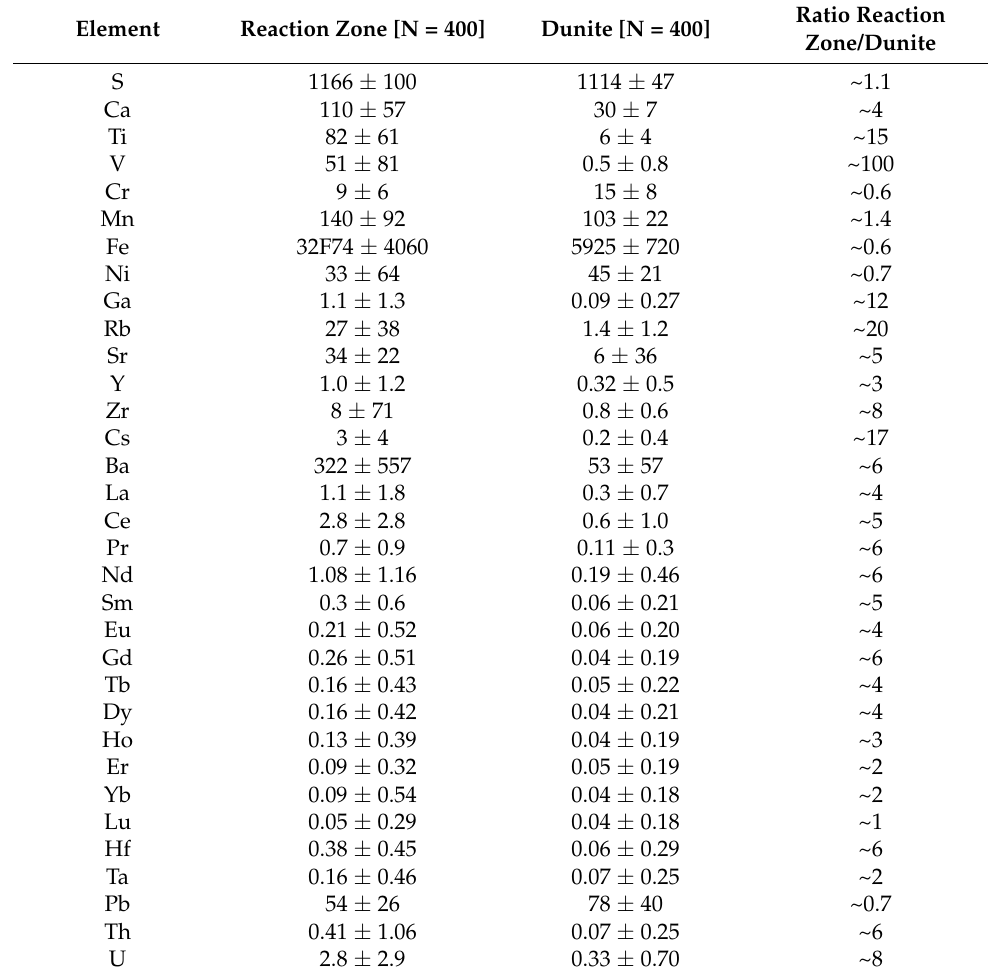
Table A1. LA-ICP-TOFMS raw element count rates. Element count rates are averaged from 400 indi- vidual LA-ICP-TOFMS measured spots of 5 µ m diameter within the reaction zone and the